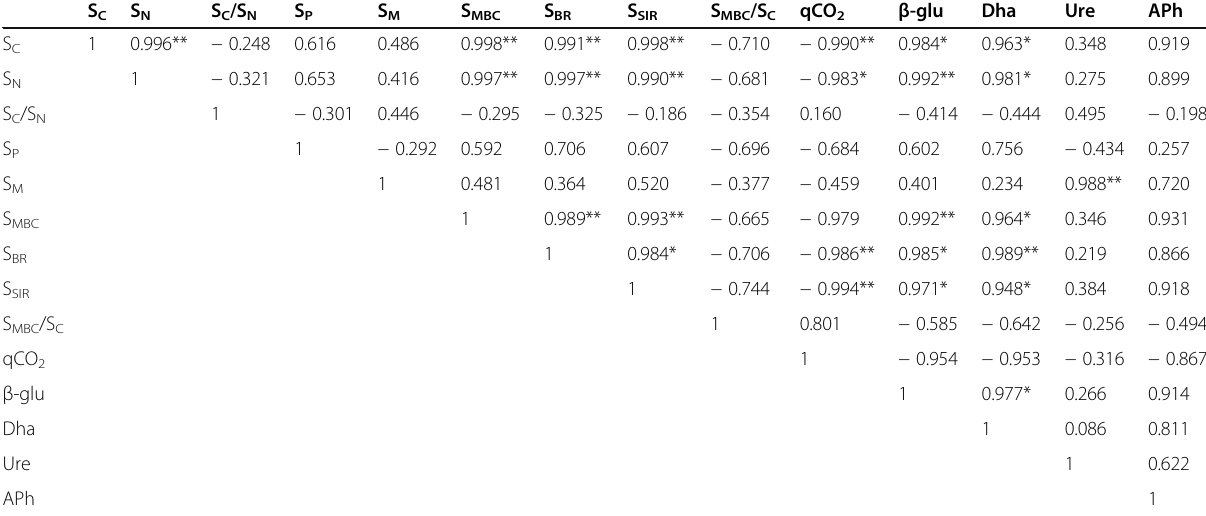
Table 2 Pearson correlation coefficients ( r ) between soil physicochemical, microbial parameters, and enzyme activities among different land uses of a semiarid region of